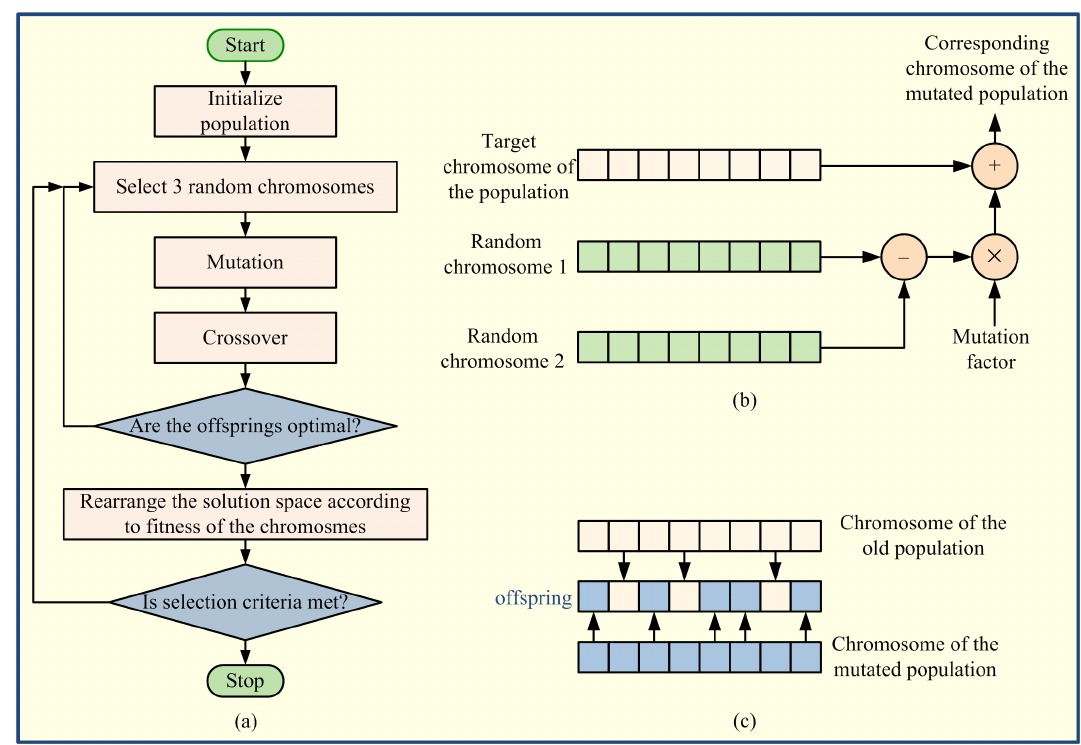
Figure 3. ( a ) Flowchart of differential evolution (DE), ( b ) mutation, and ( c ) crossover.